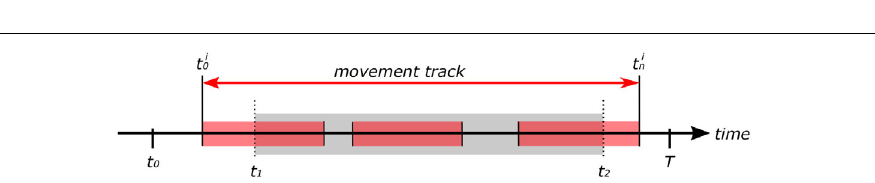
Figure 10 Diagram of the event timeline. The time from t 0 to T is the time span represented by the data set. The shaded grey area between t 1 and t 2 is the duration of the main show. The shaded red areas are detection periods of device i , which, as required, start before t 1 and end after t 2